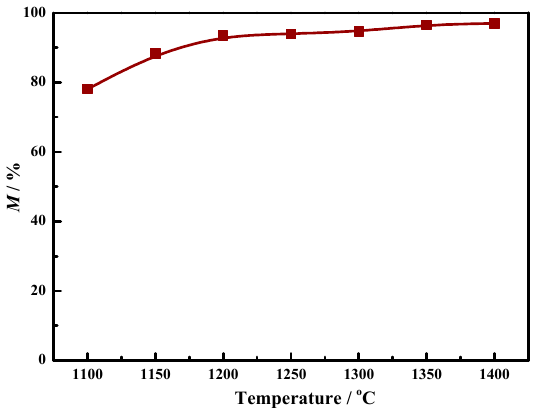
Figure 3. The effect of the temperature on the metallization degree.